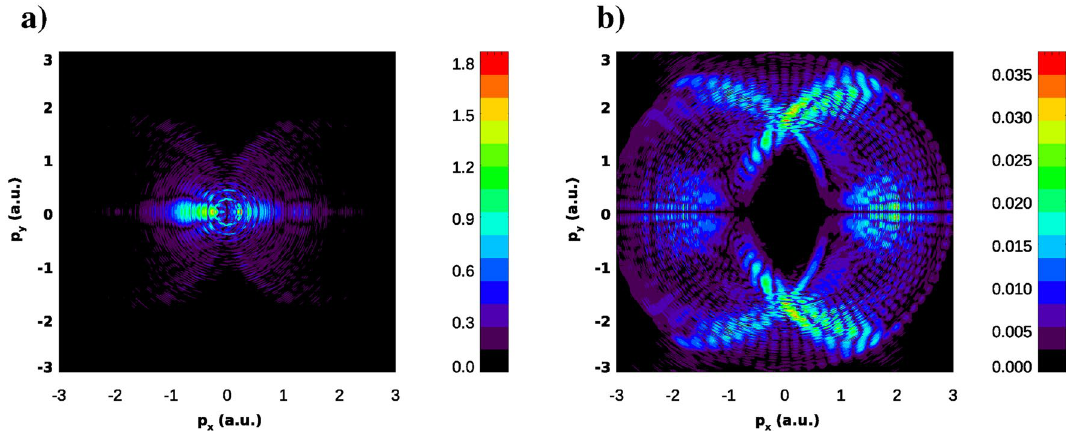
Figure 12. Unfiltered ( a ) and filtered ( b ) PMD in the ( x , y ) plane. PMD is exponentiated ( P ( p x , p y ) 1 / 3 is shown) for improving visibility of the patterns. IR field parameters: E 0 probe parameters: E 0